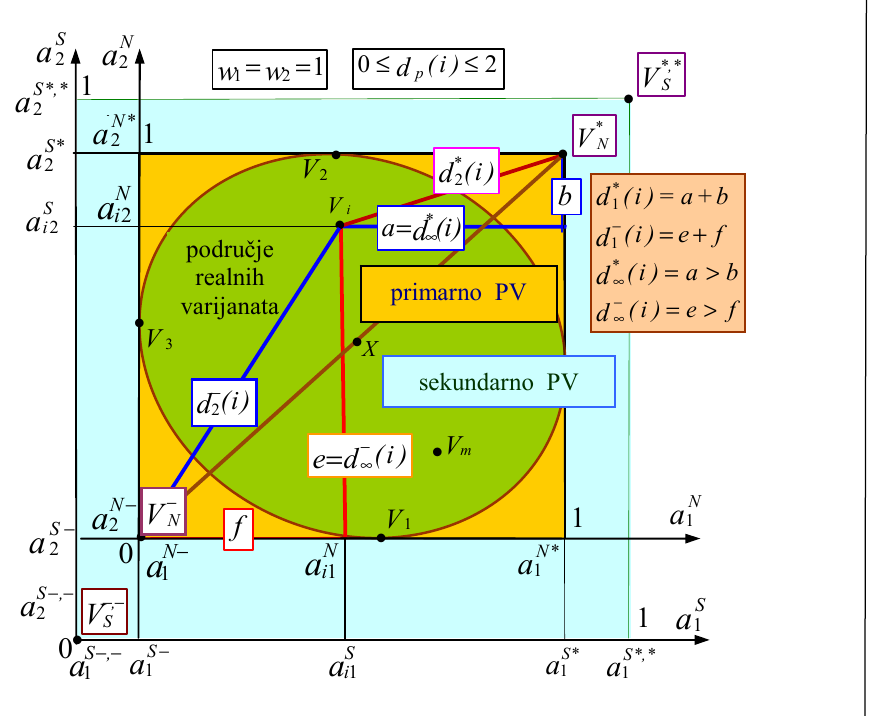
Рис . 1 – Функции Lp метрики альтернативных показателей на первичном PV для двух критериев Figure 1 – Lp functions of the V i alternative metrics in the primary SA for two criteria To su „ č ista” rastojanja Lp metrike, dobijena na osnovu pojedina č nih